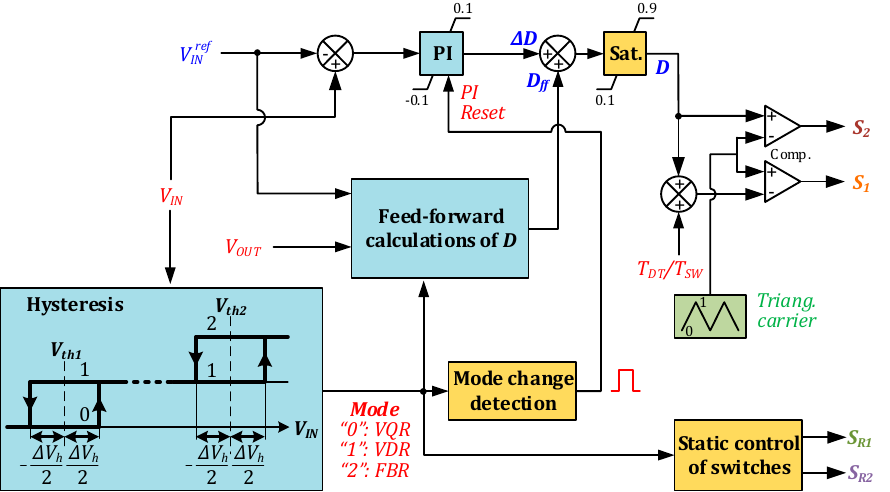
Figure 12. Control system for the converter with BHBI and MMR.